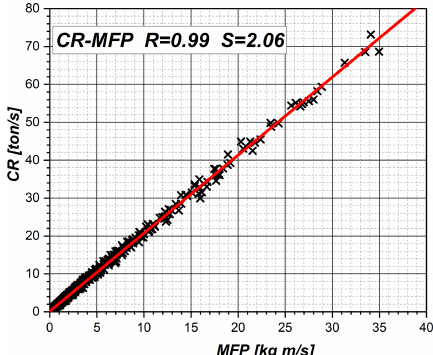
Figure 1. Scatter plot of condensation rates (CR) as a function of upward mass flux (MFP) for clouds in all groups. R is the correla- tion coefficient; S is the slope of the linear